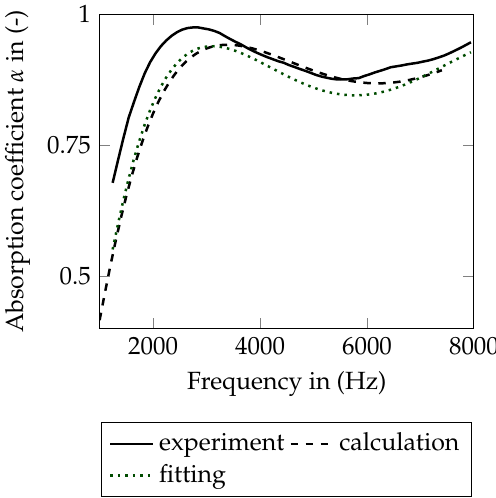
Figure 10. Calculated and fitted curves for fouled SFF